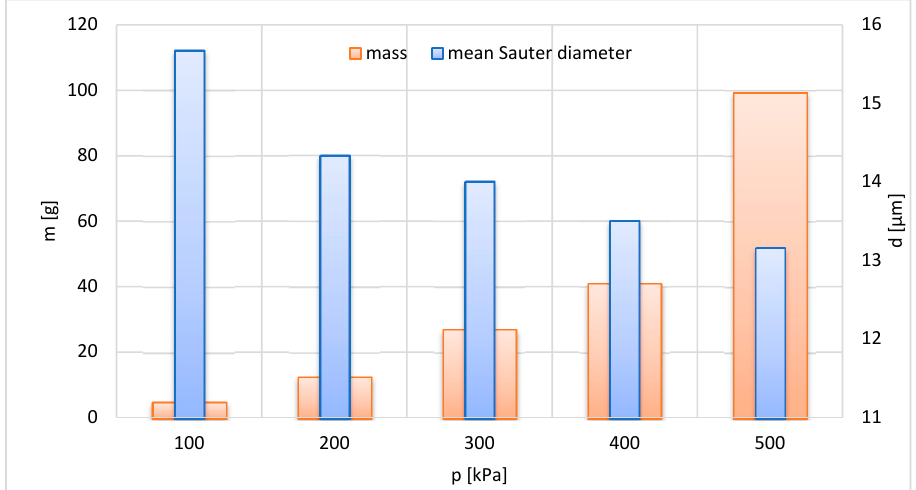
Figure 8. Effect of the pressure of working air on mass and mean Sauter diameter of grinding product; t = 1200 s, n = 150 s − 1 .